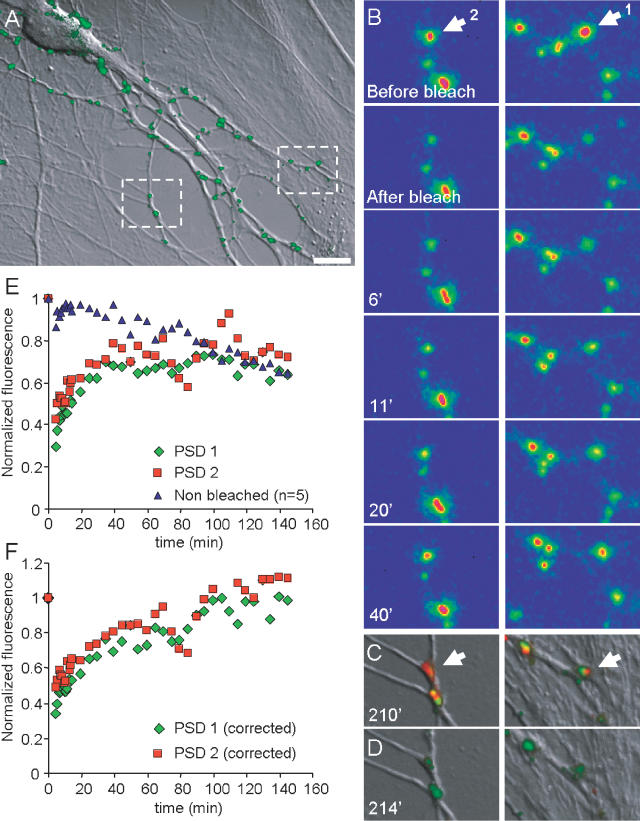
Loss and Reincorporation Rates of GFP:ProSAP2 at Individual Postsynaptic Sites(A) A fluorescence image of a neuron expressing GFP:ProSAP2 overlaid onto a DIC image of the same region. Postsynaptic sites appear as green puncta. Bar, 10 μm.(B) Two postsynaptic sites (arrows) were selectively photobleached by high-intensity laser light, reducing their fluorescence to approximately 30% to 40% of their nominal values. Fluorescence recovery at these sites was then followed by time-lapse imaging. Same regions as those enclosed in rectangles in (A). GFP:ProSAP2 fluorescence levels shown in false color as in Figure 1.(C and D) At the end of the experiment, presynaptic boutons in the field were labeled with FM4–64 (as described for Figure 1) to verify the synaptic identity of the photobleached GFP:ProSAP2 puncta. Note that the photobleached puncta (green) were juxtaposed to presynaptic boutons (red) that exhibited a capacity for evoked endocytosis (C) and exocytosis (D) of FM4–64. Only puncta with functional presynaptic counterparts were included in our analysis.(E) Fluorescence recovery time course for the photobleached GFP:ProSAP2 clusters shown in (B) as well as the mean fluorescence of five nonphotobleached clusters in the same field.(F) Fluorescence recovery time course after correcting for ongoing photobleaching.